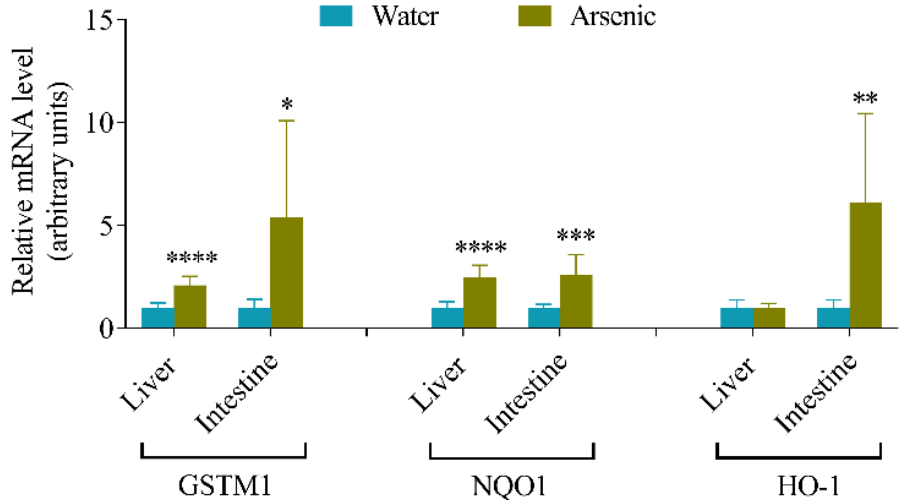
Figure 1. Effects of oral arsenic exposure on the expression of hepatic and intestinal oxidative stress responsive genes. Male mice (2–3-month-old) were exposed to sodium arsenite in drinking water